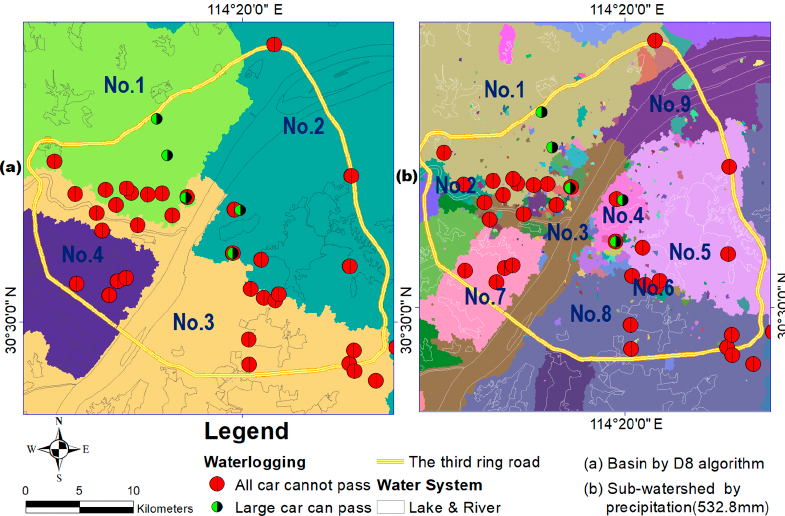
Figure 11. Overlapping the distribution of waterlogging points inside the third ring road of Wuhan City with the watershed delimitation. ( a ) Basin delimitation, which is divided by the hydrology tools